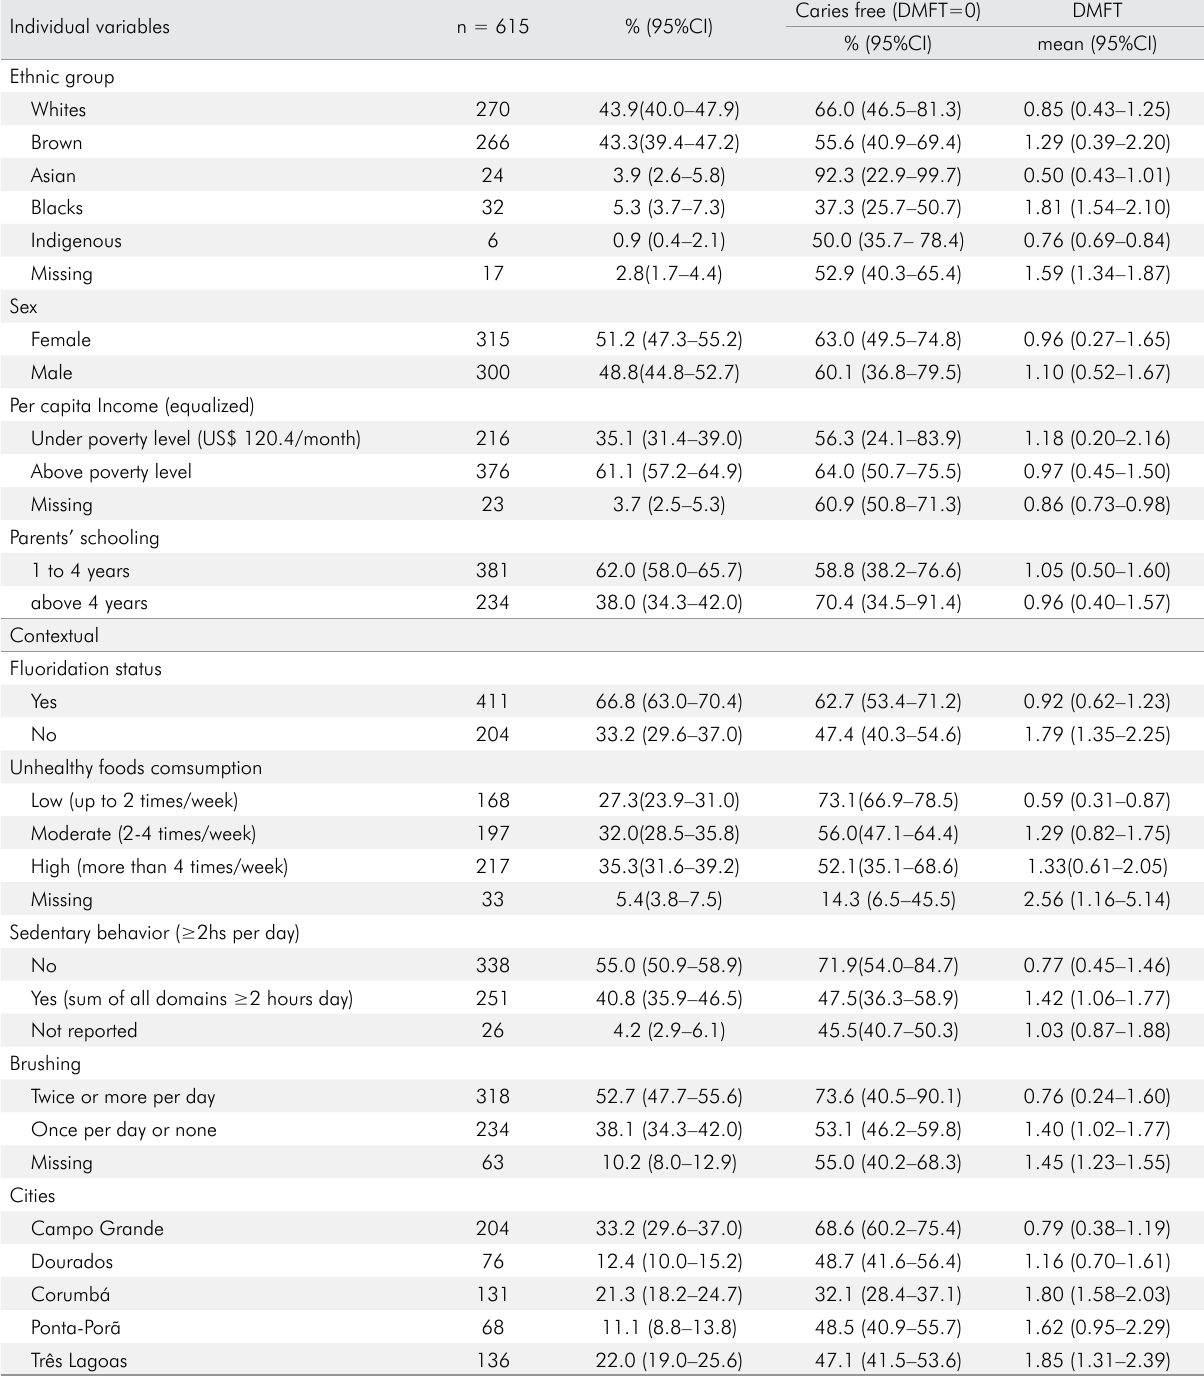
Table 1. Descriptive characteristics and proportions of the Mato Grosso do Sul - Oral Health Survey (SBMS study 2018-19), for 12 year-old (n =